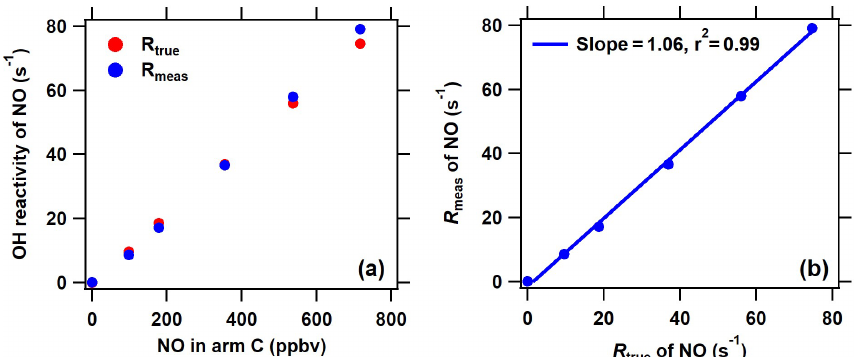
Figure 3. Comparison of the measured and true OH reactivity of NO at different NO concentrations introduced through arm C. The measured OH reactivity of NO was calculated based on the new C2 mode shown in Fig. 2 in the ICRM system.